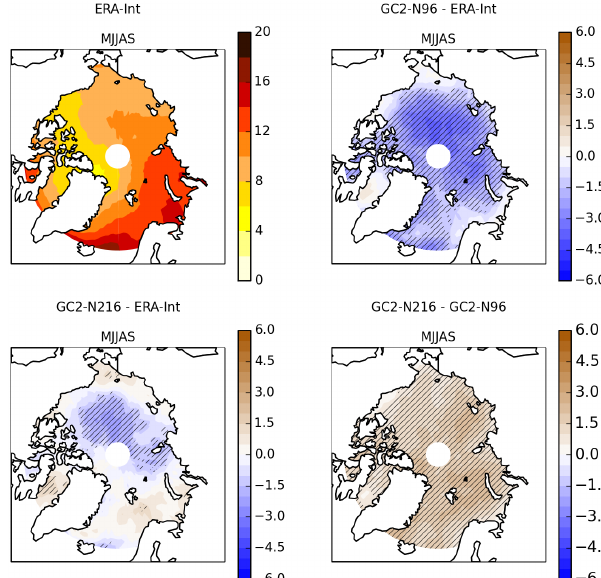
Figure 3. Vorticity-based tracking – multi-annual MJJAS mean cyclone intensity with the background field removed (10 − 5 s − 1 ): ERA-Interim, GC2-N96 minus ERA-Interim, GC2-N216 minus ERA-Interim and GC2-N216 minus GC2-N96. ERA-Interim uses the 1990–2009 MJJAS mean, while GC2-N96 and GC2-N216 use the MJJAS mean over the last 100 years of the 150-year run. Hatch- ing indicates that the difference is shown by Welch’s t test to be statistically significant at the 95% level.